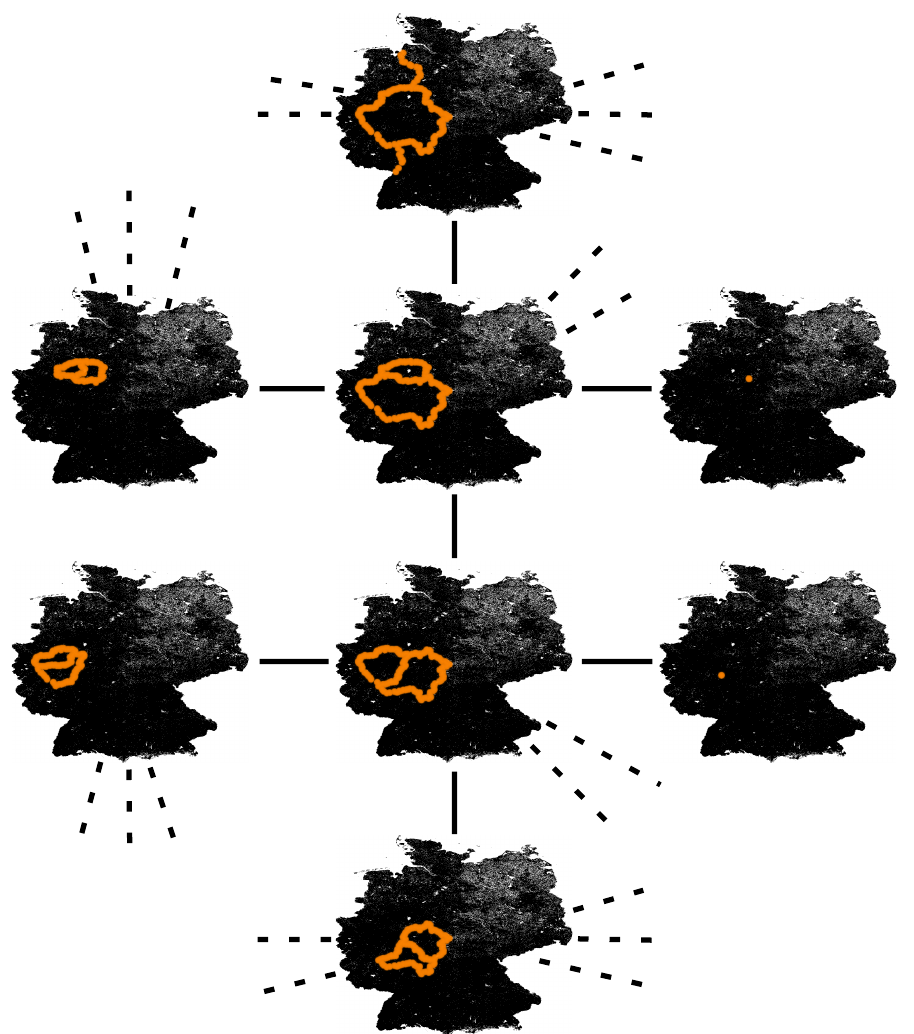
Figure 5. Visualization of a tree decomposition of Germany road graph around the largest